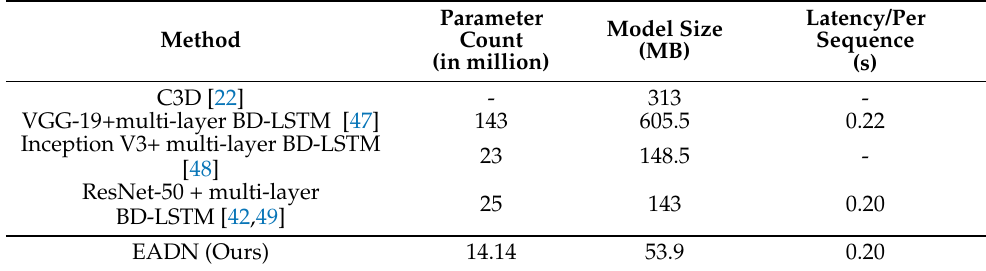
Table 7. Evaluation of EADN in terms of parameters, model size, and time complexity against the state-of-the-art